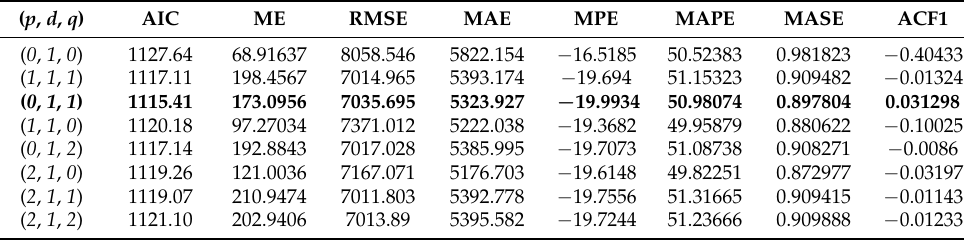
Table 4. Comparison of evaluation parameters for different models.